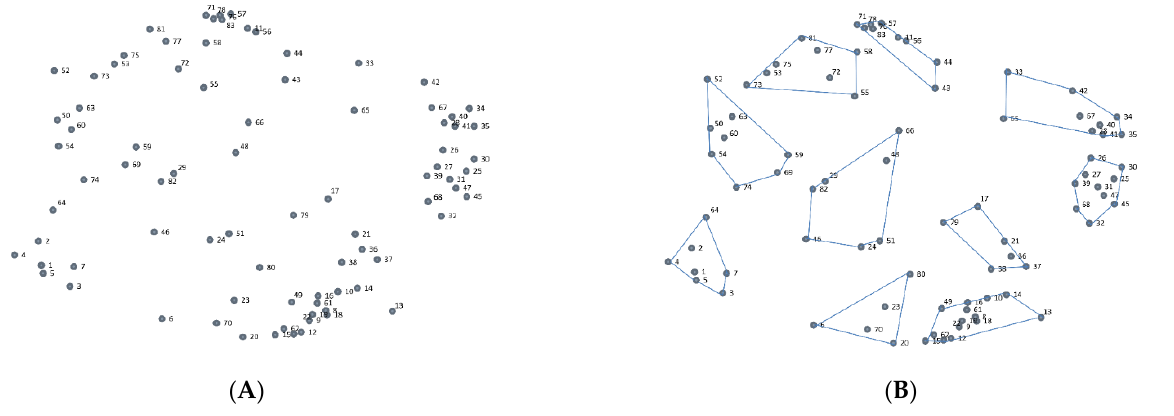
Figure 1. An example of a point map ( A ) and a possible cluster solution ( B ). Note. Dots represent individual statements that have been sorted by the participants .